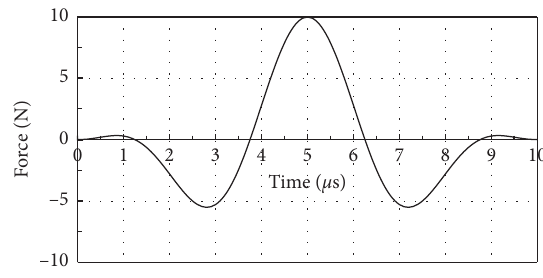
Figure 3: The load-time curve.